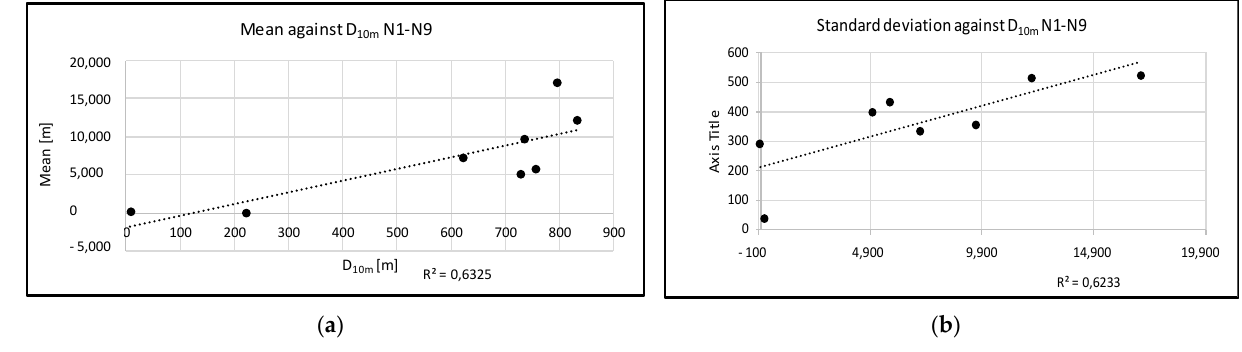
Figure 11. ( a ) Mean versus distance to 10 m isobaths D 10m , R 2 = 0.63, p = 0.0183, F = 10.3245; Standard Deviation = 292.23 + 0.0416 * distance to isobaths. ( b ) Standard deviation to distance, R 2 = 0.62, p = 0.0197, F = 9.927; Mean = 212.3691 + 0.0210 * distance to isobaths.